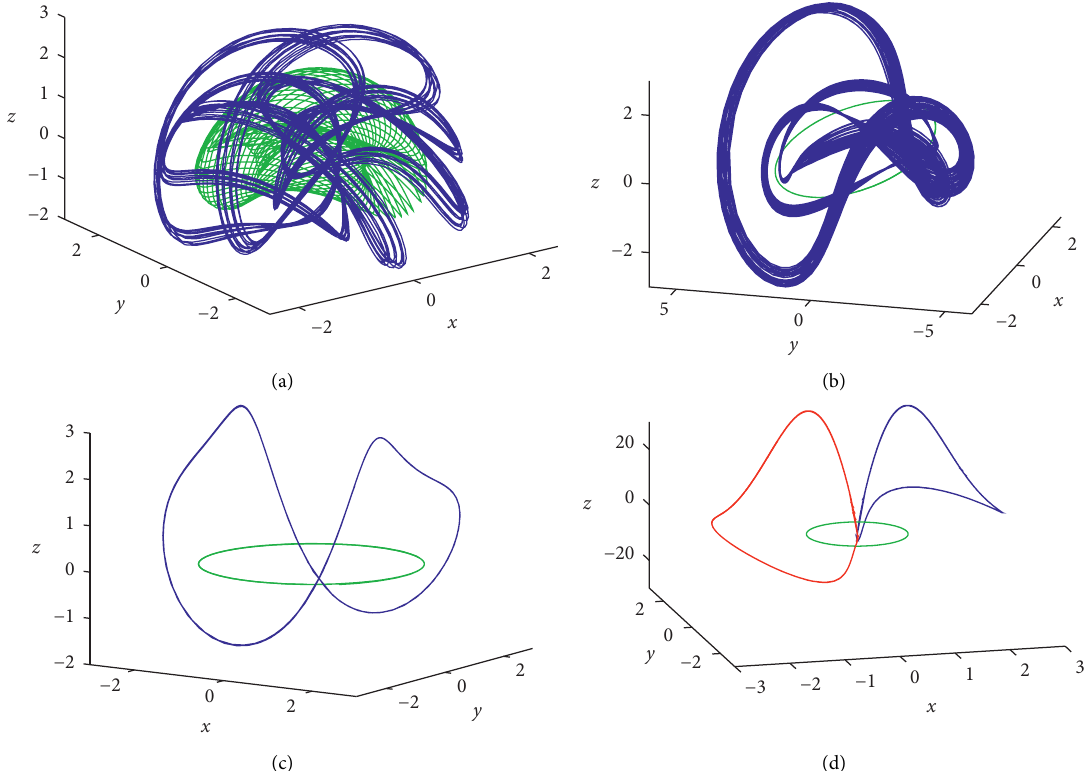
Figure 3: Coexisting chaotic flow of system (1) for c � 1 at various values of a . (a) Chaotic flow coexists a torus for system (1) with a �− 1, b � 0. (b) Chaotic flow coexists limit cycle for system (1) with a �− 6.17, b �− 1. (c) Two limit cycles coexisting for system (1) with a �− 4.5, b � − 1. (d) Three limit cycles coexisting for system (1) with a �− 0.8, b � − 1.